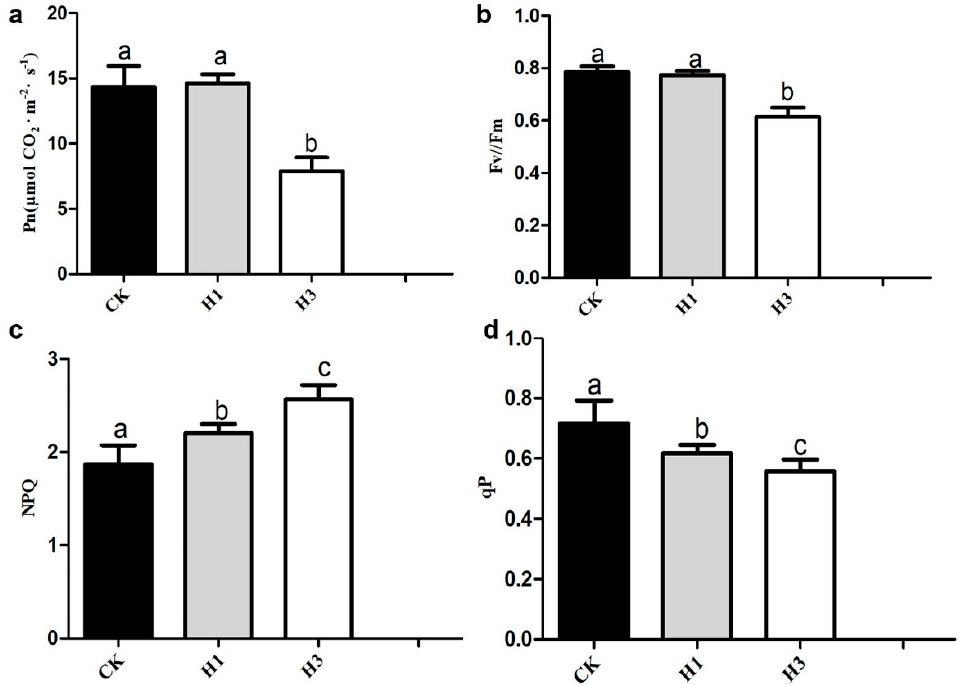
Figure 3. Measurement of photosynthetic parameters and chlorophyll fluorescence parameters under heat stress. ( a ) Pn, the net photosynthetic rate, ( b ) Fv/Fm, the maximum photochemical efficiency of PSII, ( c ) NPQ, the nonphotochemical quenching, ( d ) qP, the photochemical quenching coefficient. CK, control group; H1, group with heat stress treatment for 1 d; H3, group with heat stress treatment for 3 d.